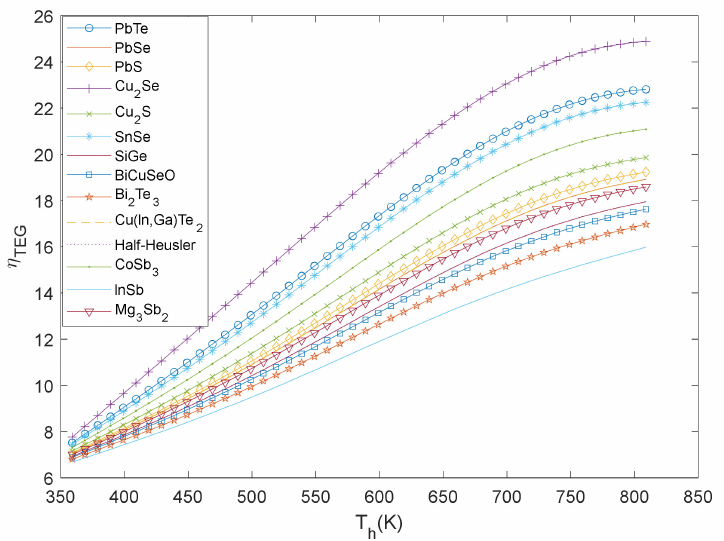
Figure 2. Changes in the efficiency of TEG materials considering the variation in TEG material and hot-side temperature in the constant cold-side temperature of 300